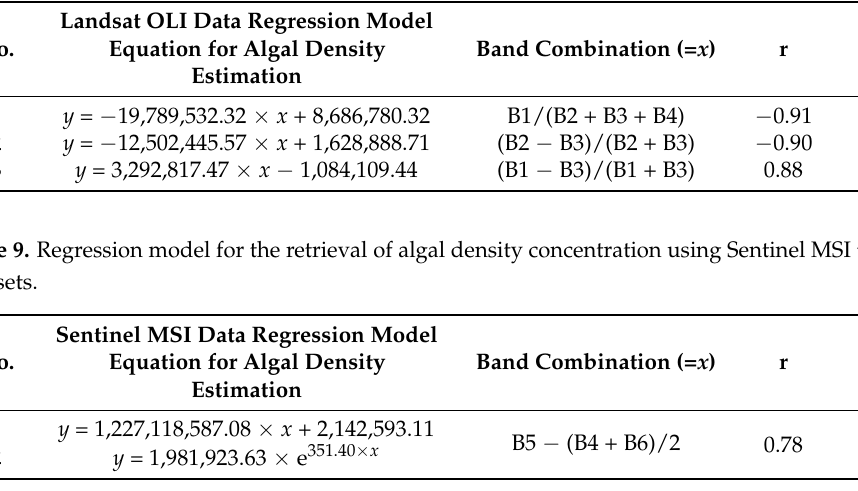
Table 8. Regression model for the retrieval of algal density concentration using Landsat OLI training datasets.